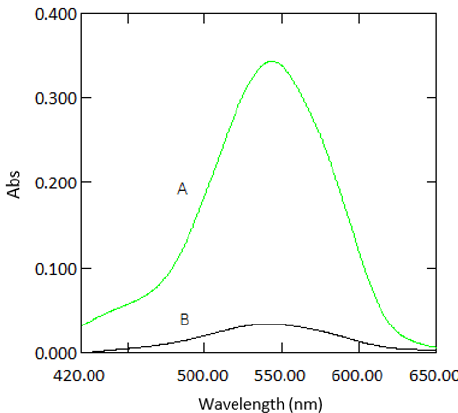
Figure 2. Absorption spectra of a sample containing 1 mg · L − 1 Cr VI with reagents measured in 10 mm cuvettes ( A ) and 1 mm quartz cuvettes ( B ) against reagent blank.